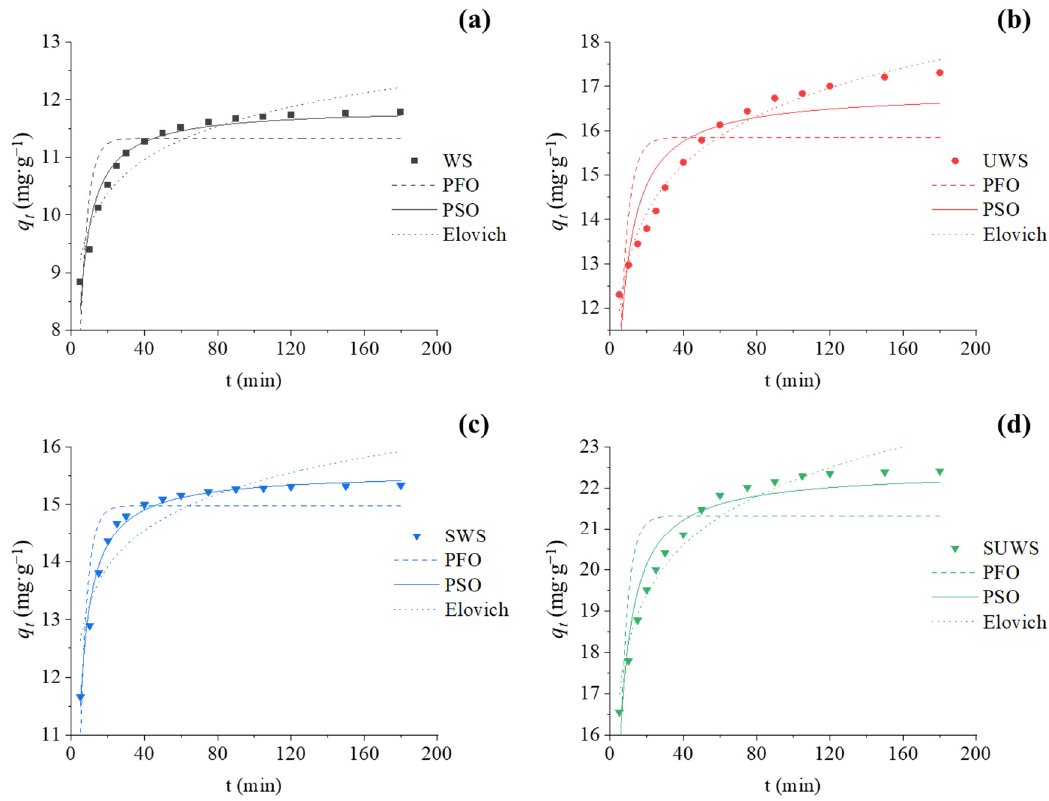
Figure 5. Kinetic data for the adsorption of CV onto the biosorbents: ( a )—WS; ( b )—UWS; ( c )—SWS; ( d )—SUWS. Comparison between the experimental data (points) and predictions (lines) of the PFO, PSO and Elovich models.